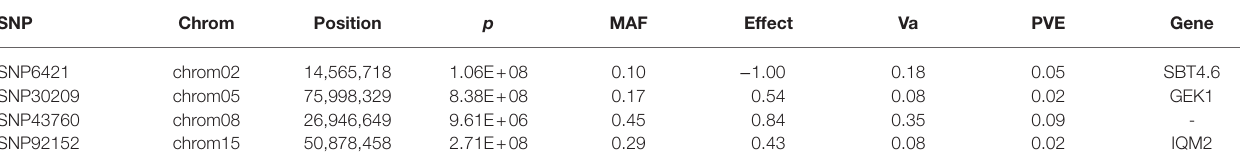
TABLE 1 | SNPs identified through the GWAS model.